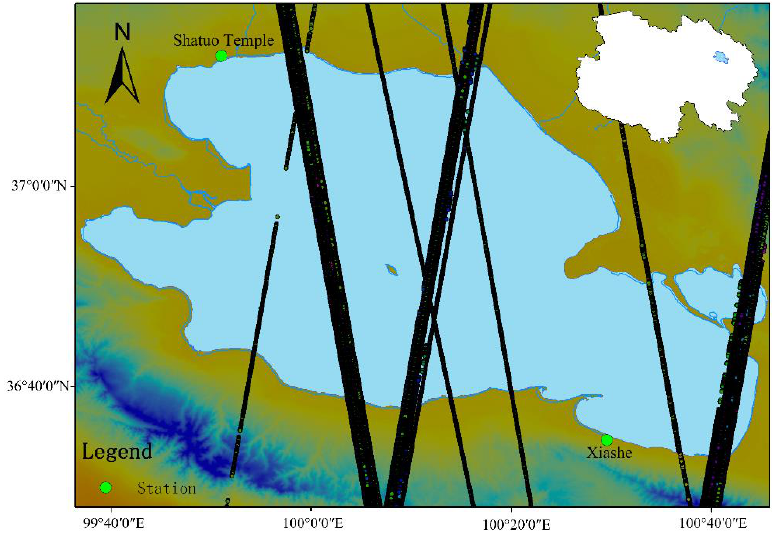
Figure 1. Location of Lake Qinghai (blue polygon) in Qinghai Province (white polygon), gauging stations (green points) and all of the ICESat tracks (black